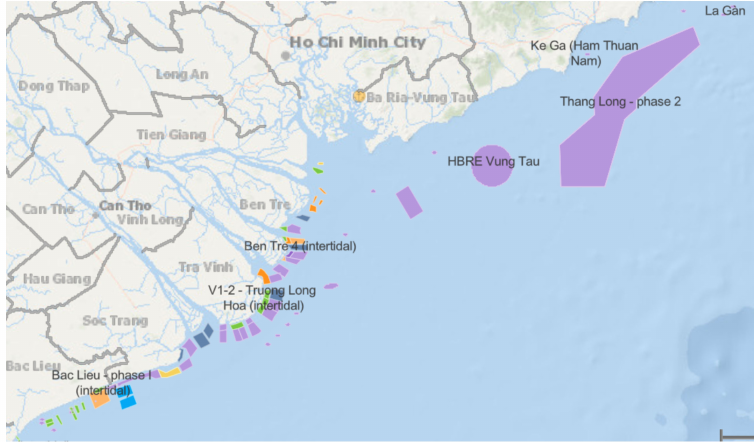
Figure 8. Vietnam offshore wind energy project locations (Source: 4C Offshore Ltd.).